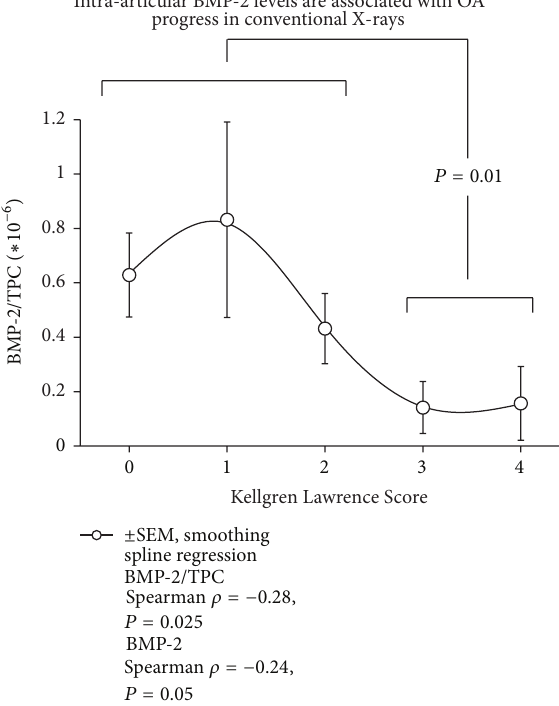
Figure 3: High levels of BMP-2 are associated with a low degree of OA related radiological changes (Kellgren Lawrence Score). Results of the Spearman correlation are indicated for absolute BMP-2 levels and concentrations in relation to the total protein content (TPC) on the right side. Statistical significance (Kruskal-Wallis H -Test) describes results comparing mild (KLS 0–2) and severe OA (KLS 3 - 4 ). A smoothing spline regression for plane curves was chosen in order to illustrate the S-shaped character of the curve; values are shown with ±